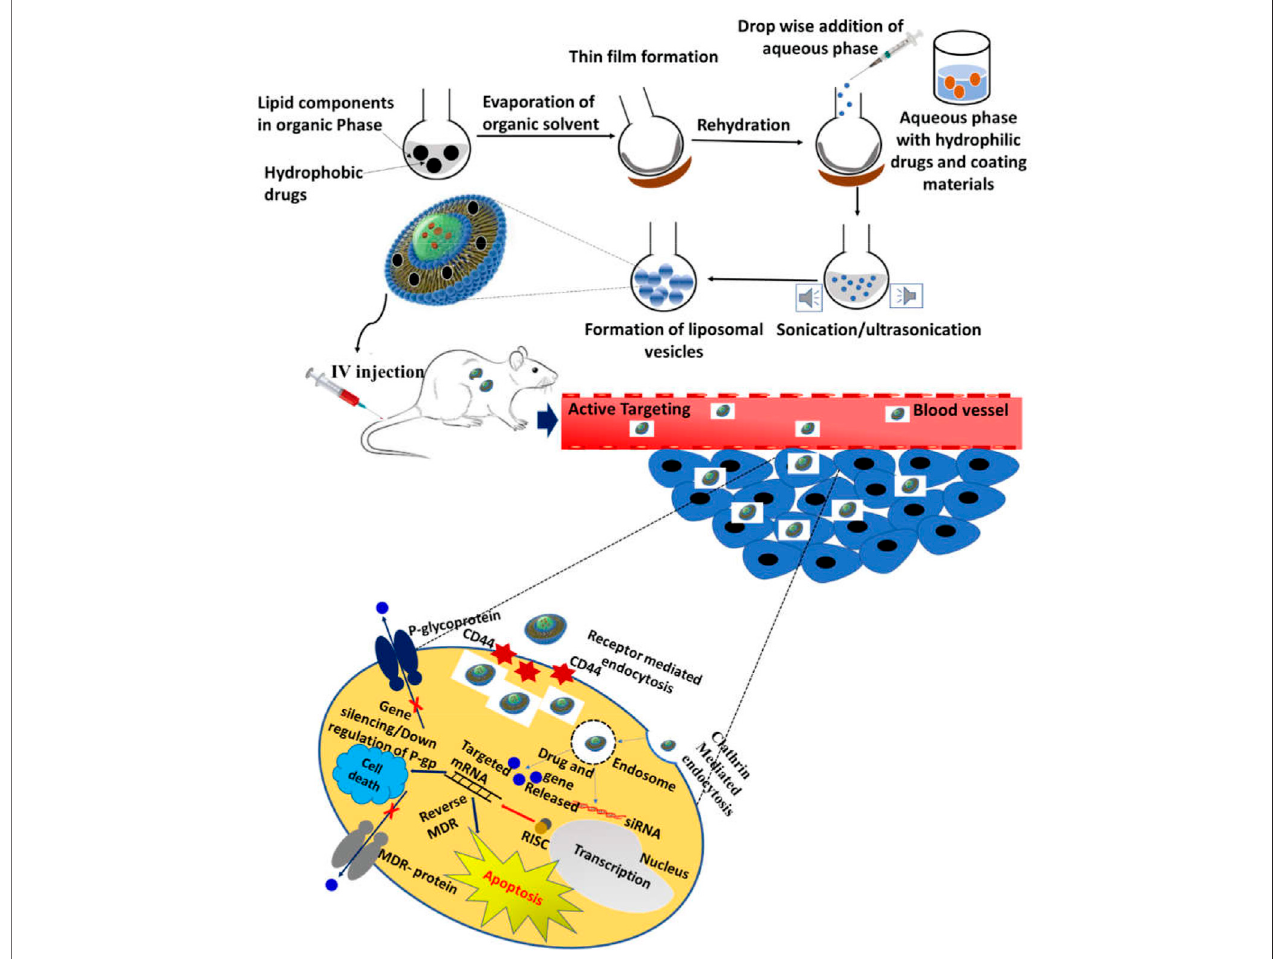
FIGURE 5 | Schematic illustration of liposome-based CD44-targeted delivery of anticancer drugs/genes.